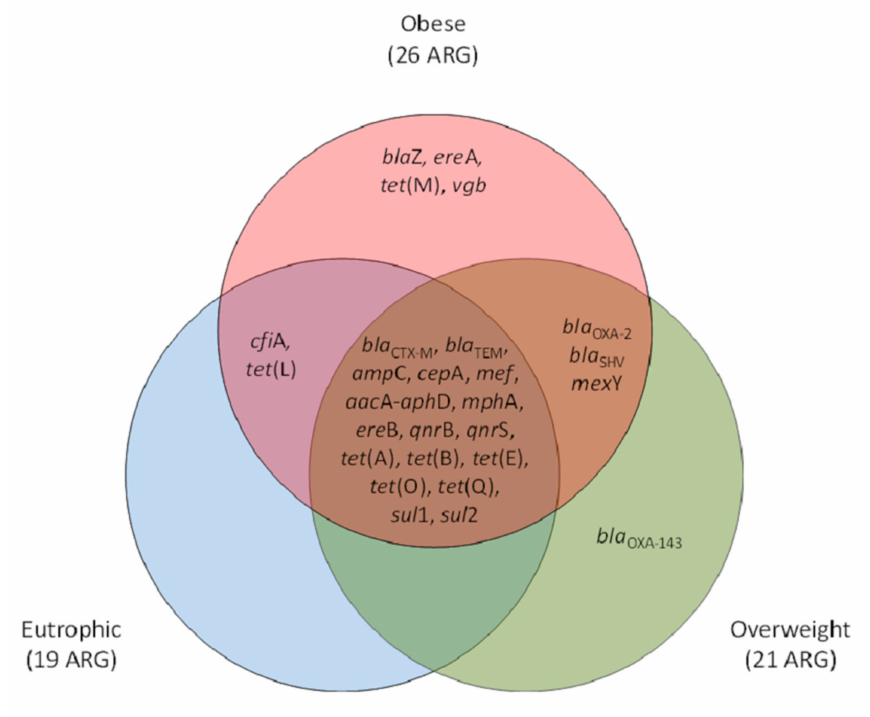
Figure 2. Venn diagram representative of the antimicrobial resistance genetic markers (ARG) occurrence and qualitative clustering according to their positive screening exclusively or shared between eutrophic, overweight, and obese individuals. β -lactams ( amp C, bla CTX-M , bla TEM , bla SHV , bla OXA-2 , bla OXA-143 , cfi A, cep A, bla Z, mef ); tetracyclines ( tet (A), tet (B), tet (E), tet (L), tet (M), tet (O), tet (Q)); macrolides, lincosamide and streptogramin group (MLS) ( mph A„ ere A, ere B, vgb ); quinolones ( qnr B, qnr S); sulfonamides ( sul 1, sul 2); aminoglycosides ( aacA-aphD ); and e ffl ux pumps ( mex